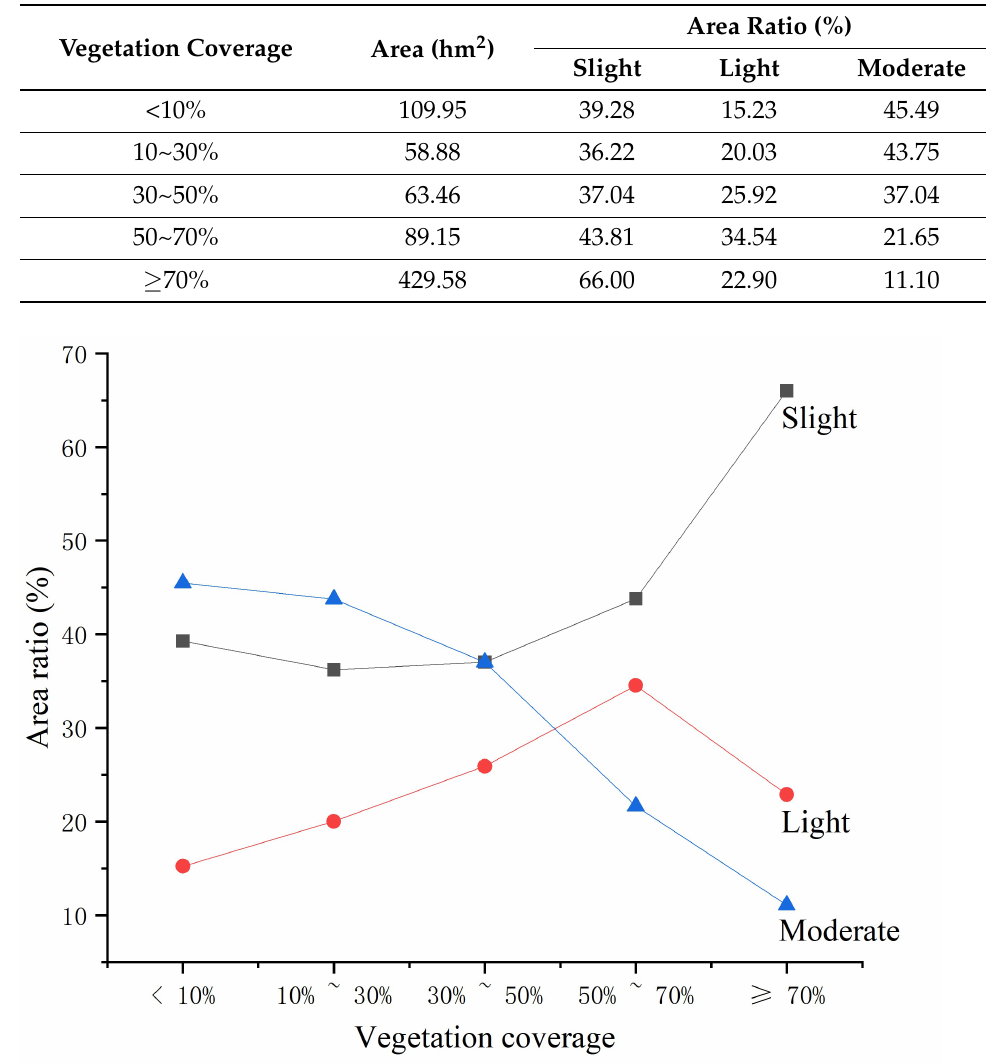
Table 5. Soil erosion intensity of different vegetation coverages.